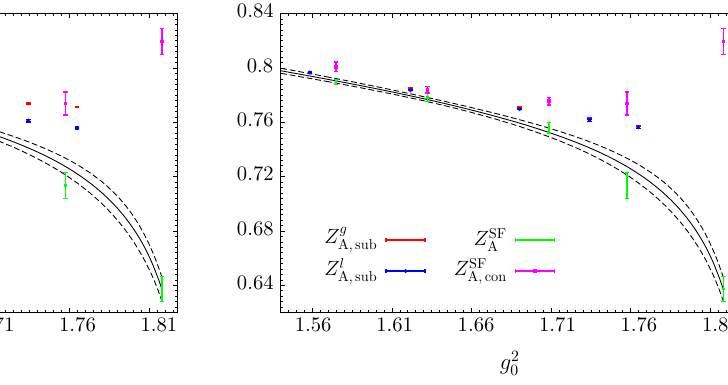
, respectively, of that A , 0 alsogivenin[22] A → 0 0